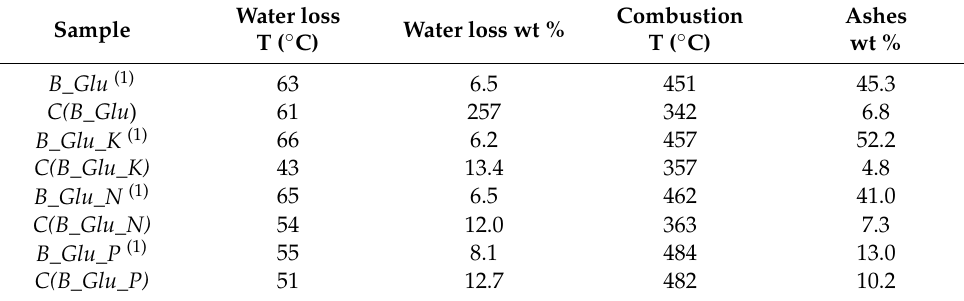
Table 3. Thermal analysis results.